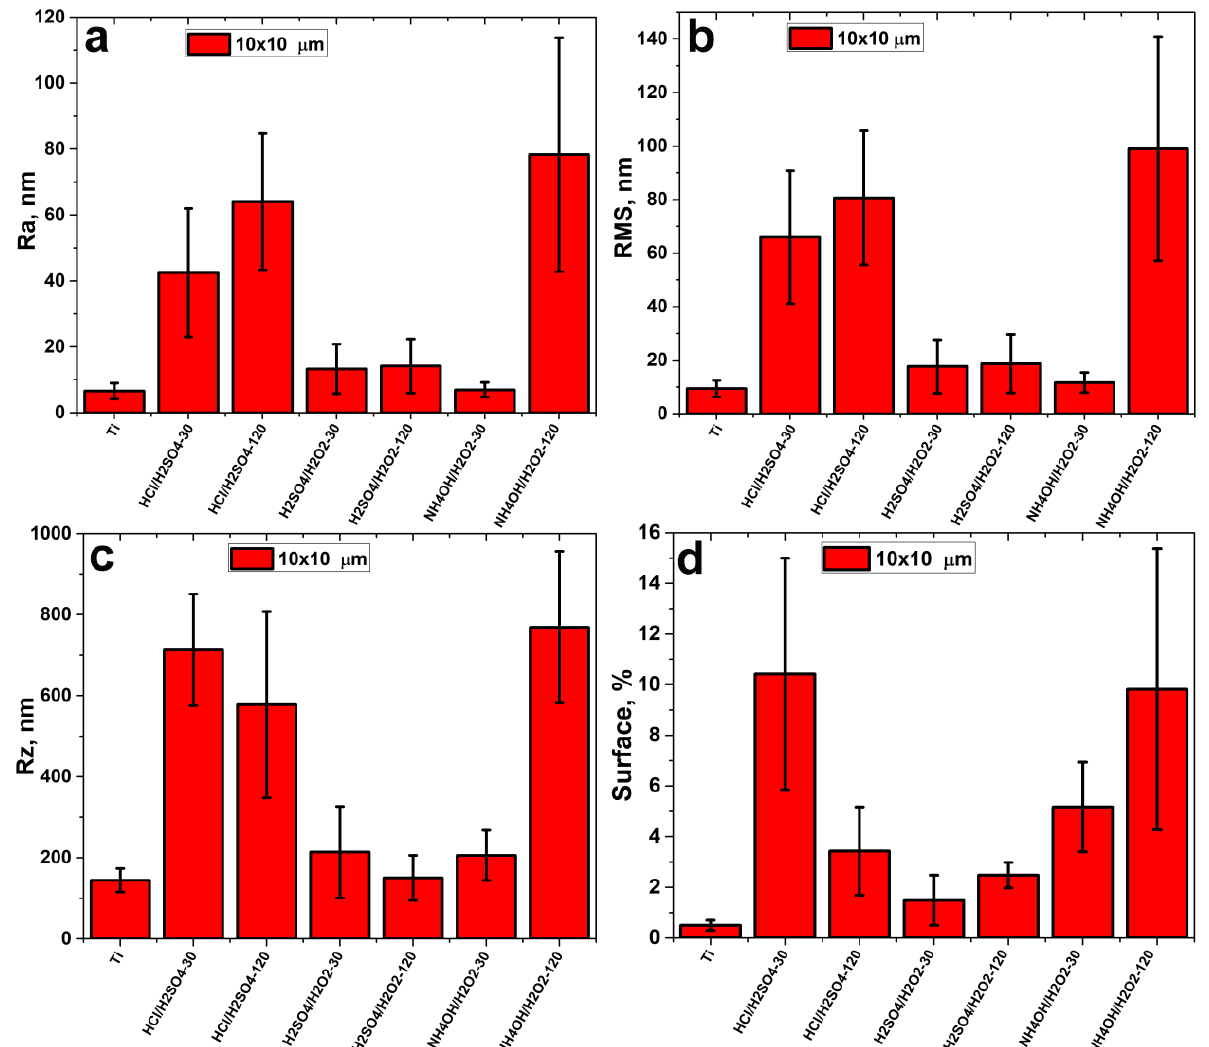
Figure 4. AFM topography parameters for etched nitinol samples: average roughness (Ra) — ( a ), root mean square roughness (RMS) — ( b ), the vertical range (Rz) — ( c ), and specific surface area — ( d ).